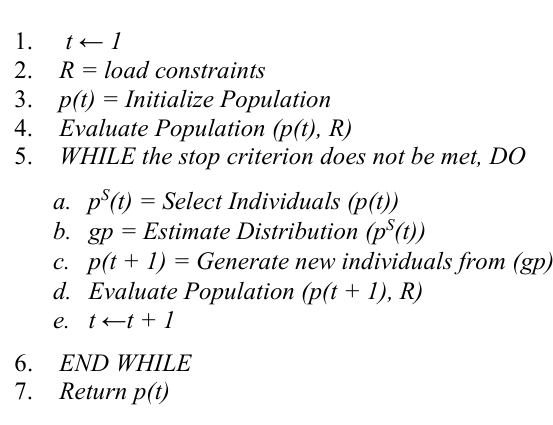
Algorithm 1. Pseudo-code of an EDA algorithm in its classical form